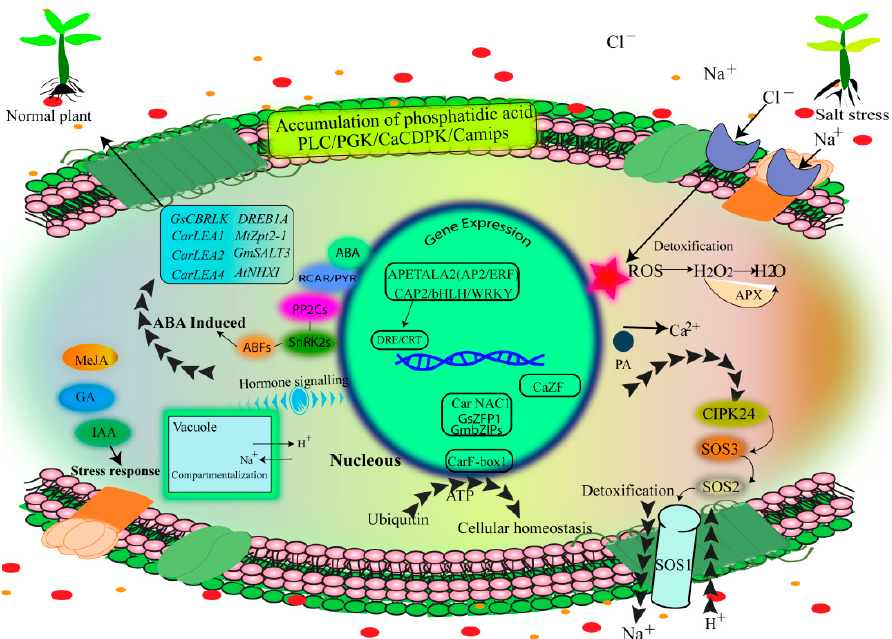
Figure 3. Schematic representation of salinity tolerance mechanism in Legumes. Reactive oxygen species (ROS), Ca 2+ and ABA are activated under SS. SS induces synthesis of ABA, which, in turn, upregulates the transcription of ion transporter genes. Overexpression of transcription factors ( GmbZIPs , GmNACs , GsZFP1 , AP2 / ERF , CarF box-1, and CarNAC , CAP2 ) have been reported under salinity.